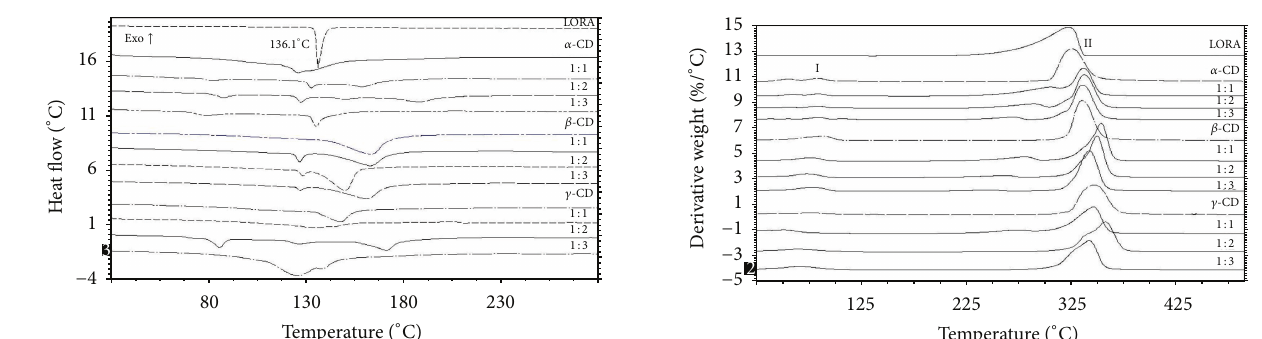
Table 1: Loss of mass obtained by DTG (TG derivative) of LORA, of the 𝛼 -CD, 𝛽 -CD, and 𝛾 -CD complexes (ratios 1: 1, 1: 2, and 1:3). Sample